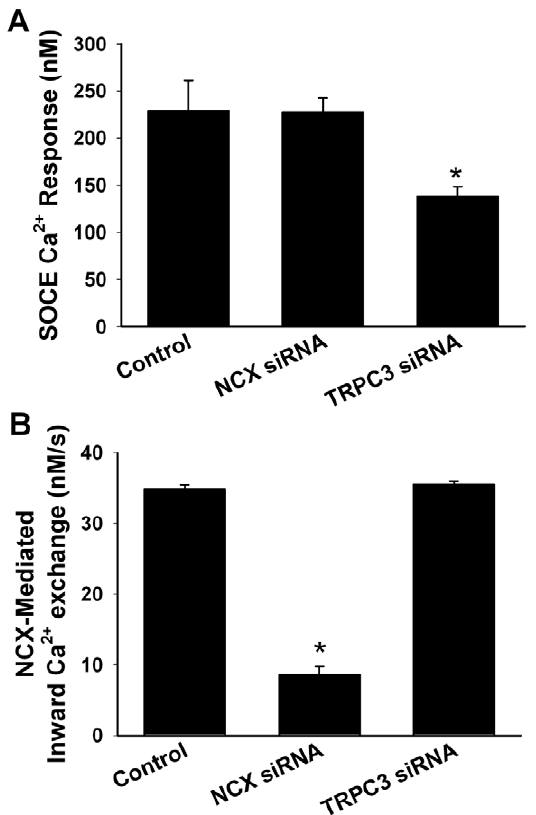
Figure 4. Relative contribution of SOCE vs. NCX to observed inward Ca 2 + fluxes. (A) The extent of SOCE (evaluated using previously published protocols [37]) was substantially blunted by siRNA targeting one of the major mechanisms SOCE in human ASM